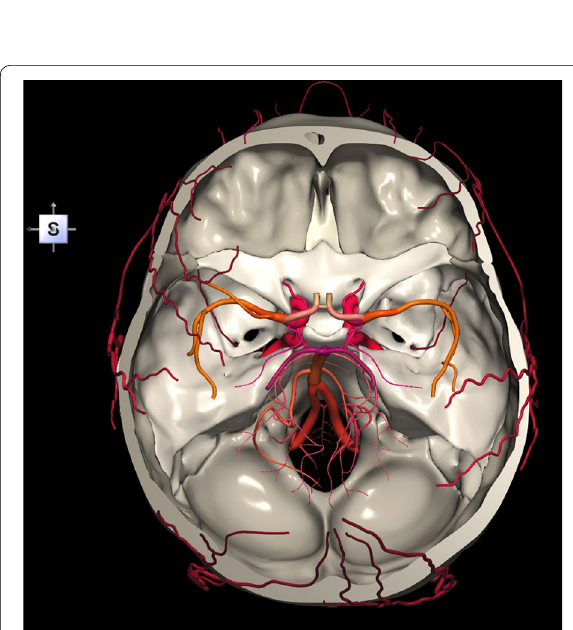
Fig. 4 Skull base along with selected intracranial arteries (internal carotid artery, vertebral artery, basilar artery, middle cerebral artery (M1 and M2 segments), posterior cerebral artery (P1 and P2 segments) and circle of Willis) and selected extracranial arteries